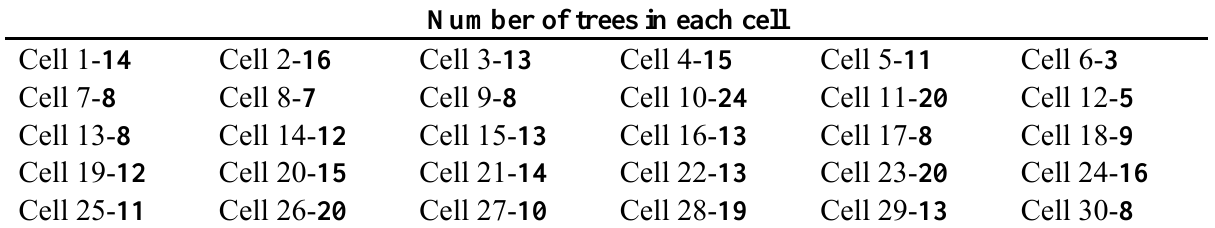
Table 2. Number of first-tier trees in 30